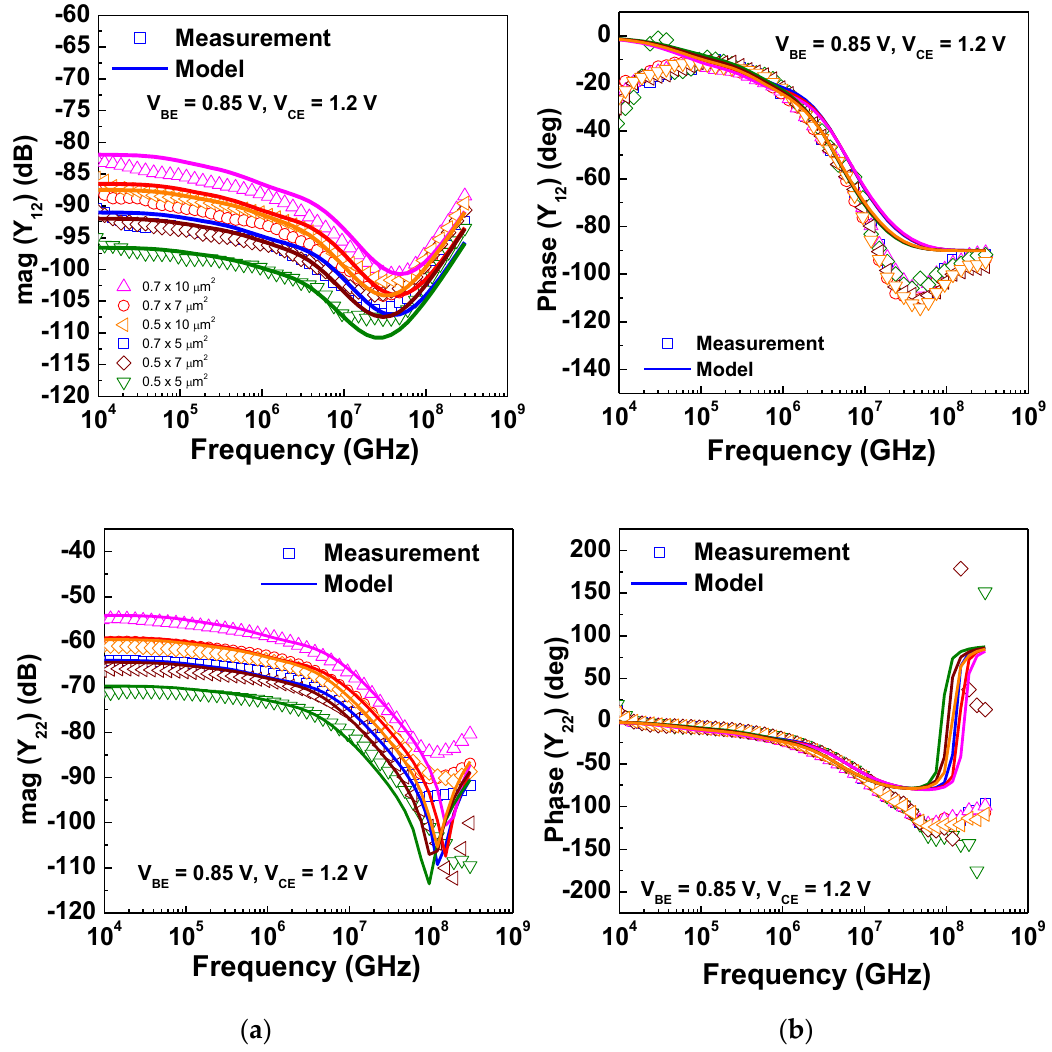
Figure 10. Comparison of the magnitudes ( a ) and phases ( b ) of the measured low-frequency Y -parameters (solid symbols), Y 12 and Y 22 , and the scalable thermal model simulation (solid lines) for different geometries.